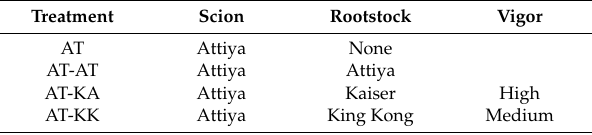
Table 1. Grafting combinations used in the